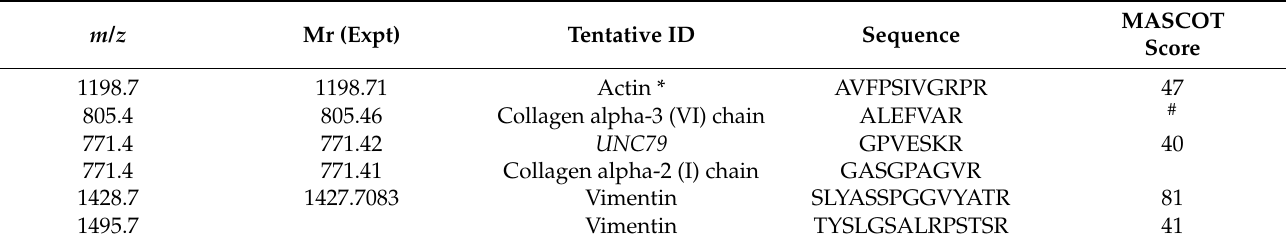
Table 3. Summary of the tentative peptide identification by in situ MS/MS